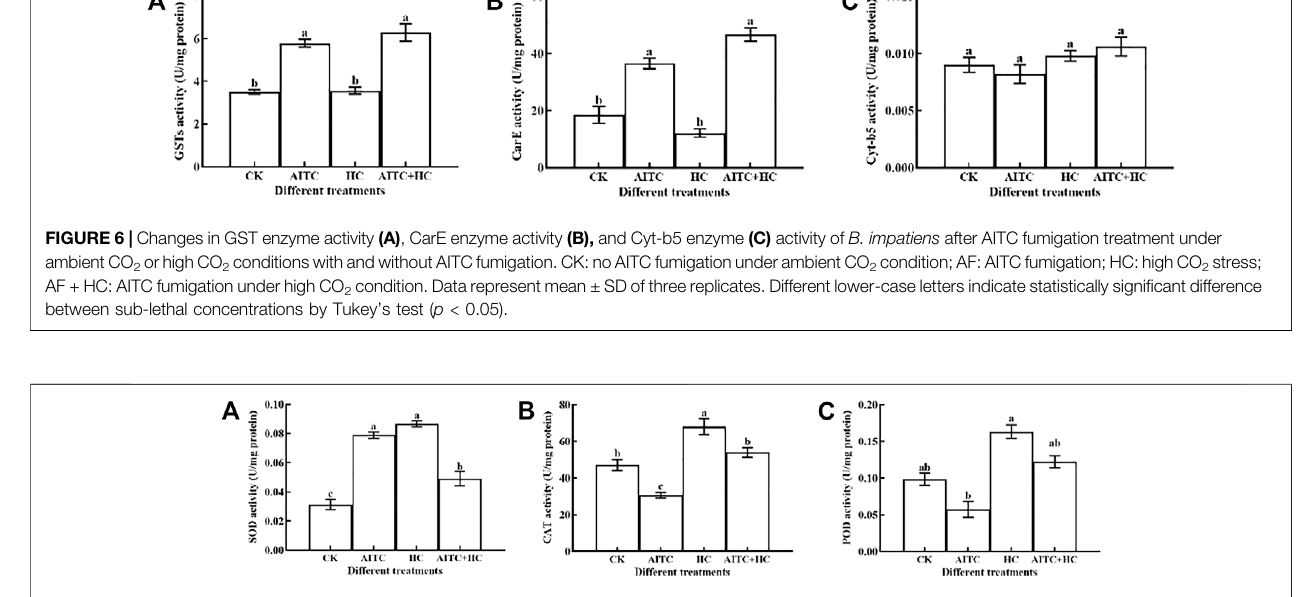
FIGURE 7 | Changes in SOD enzyme activity (A) , CAT enzyme activity (B) , and POD enzyme activity (C) of B. impatiens after AITC fumigation treatment under ambientCO 2 orhighCO 2 conditionswithandwithoutAITCfumigation.CK:noAITCfumigationunderambientCO 2 condition;AF:AITCfumigation;HC:highCO 2 stress; AF + HC: AITC fumigation under high CO 2 condition. Datarepresent mean ± SD of three replicates. Different lower-case letters indicate statistically signi fi cant difference between sub-lethal concentrations by Tukey ’ s test ( p <